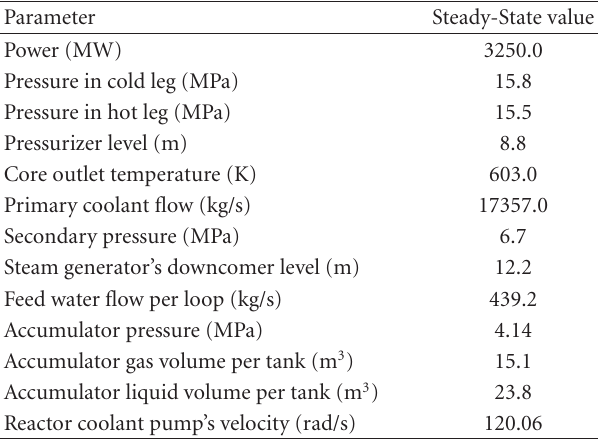
Table 1: Steady-State main parameters.